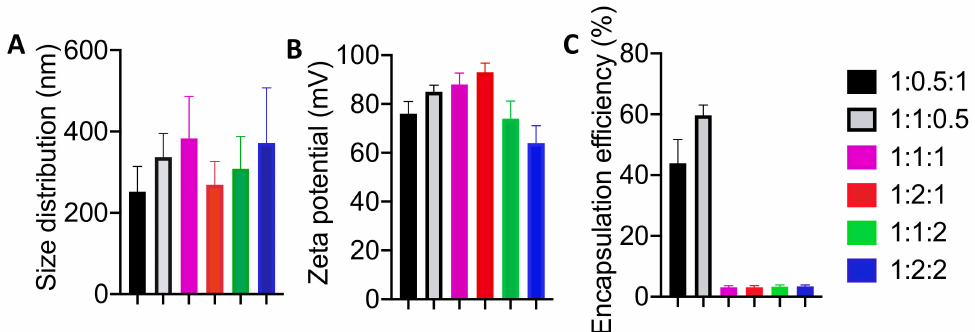
Figure 2. Size, zeta potential, and encapsulation e ffi ciency amongst the various ratios of miconazole:cholesterol:sodium oleate. ( A ) Size distribution and ( B ) zeta potential remained relatively similar, however high variation between vesicles eliminated consideration for 1:1:1 and 1:2:2 due to an inordinate number of vesicles stretching beyond the nano-range. ( C ) Encapsulation e ffi ciency amongst the various ratios eliminated several formulations from consideration due to poor performance in relation to drug delivery, while two ratios conversely displayed exceptional loading potential. All data are presented as mean ± SE ( n = 3).